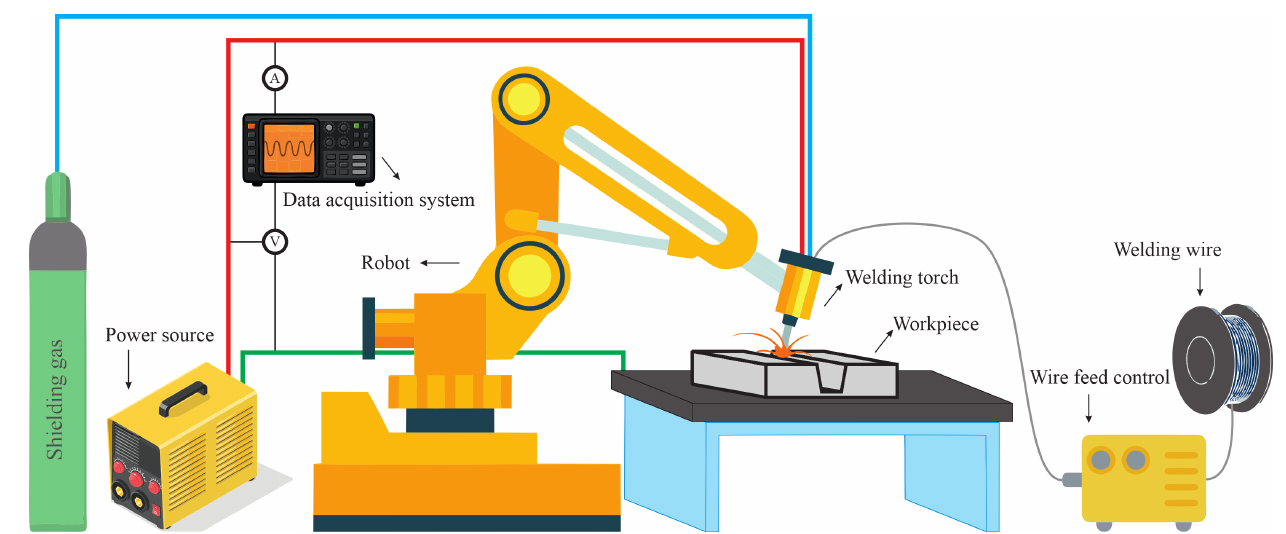
Figure 3. Schematic of the experimental setup utilised in the present